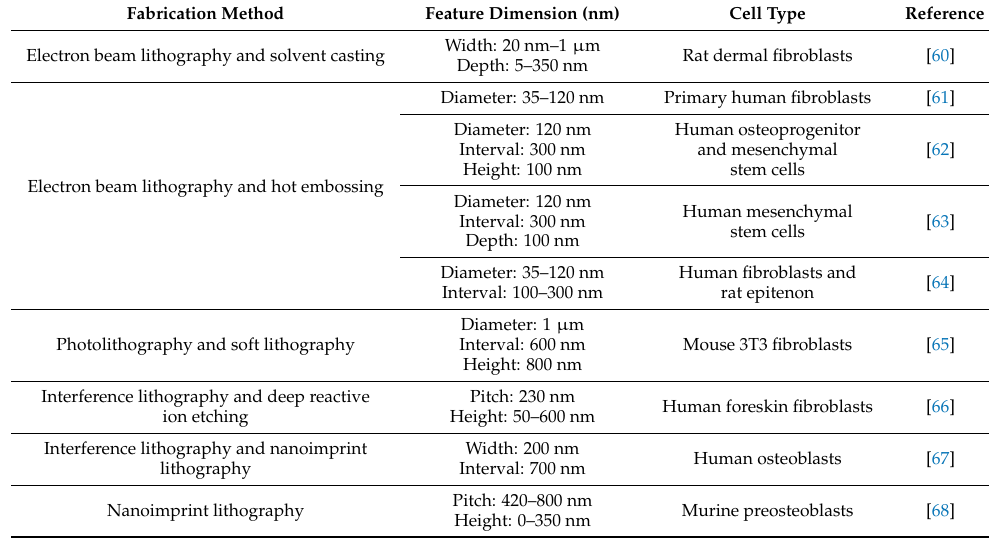
Table 1. Examples of fabrication methods to fabricate sub-micron features used in cell